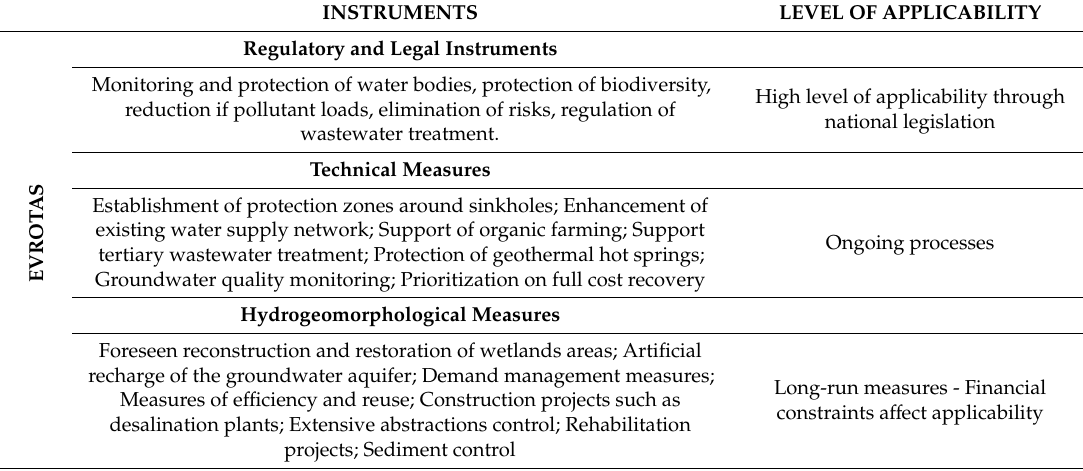
Table 1. Instruments to address water scarcity and level of applicability